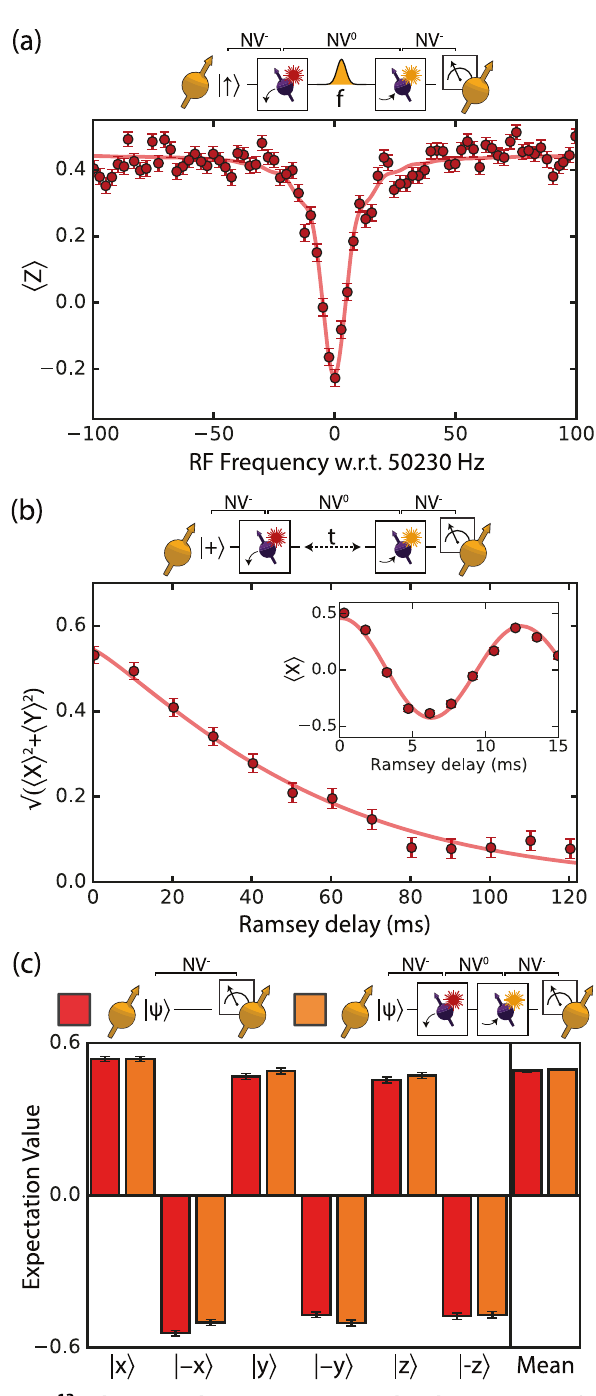
Fig. 3 13 C dynamics during ionisation and recharging. a Nuclear magnetic resonance spectroscopy after heralded preparation of NV 0 . Solid line is a numerical evaluation of the optical Bloch equations for this system (see Methods). b Free induction decay of the nuclear-spin coherence in NV 0 . Inset: Ramsey fringes mea- sured during the fi rst 15 ms of free evolution (arti fi cial detuning of 80 Hz with respect to 50230 Hz). Solid lines are fi ts (see Methods). c Protection of an arbitrary data qubit state under NV charge cycling. Orange (red) bars correspond to measurements with a charge-state cycle (idling in NV − ) between nuclear-spin initialisa- tion and readout. The data is post-selected on fi nding the NV in the negative charge state at the end of the measurement (see